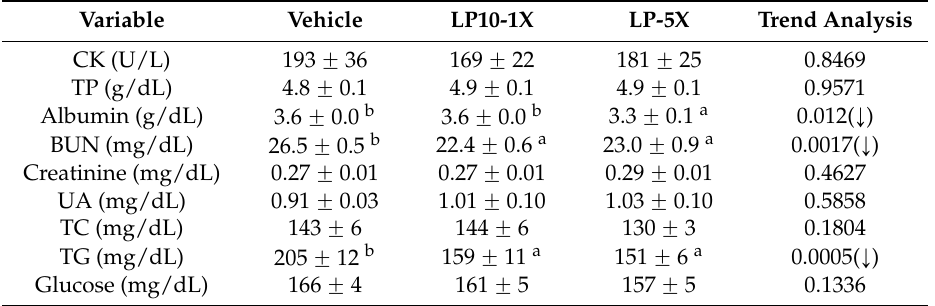
Table 2. Biochemical analysis with LP10 supplementation at the end of the